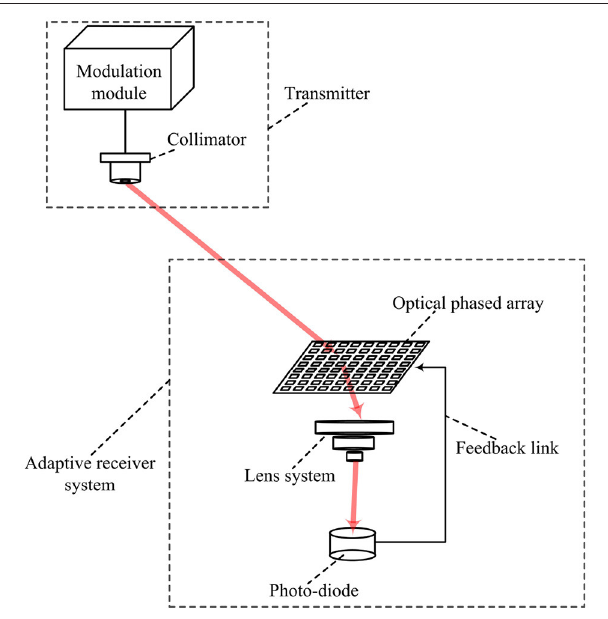
FIGURE 1 | Structure of FSO receiver system with adaptive alignment.